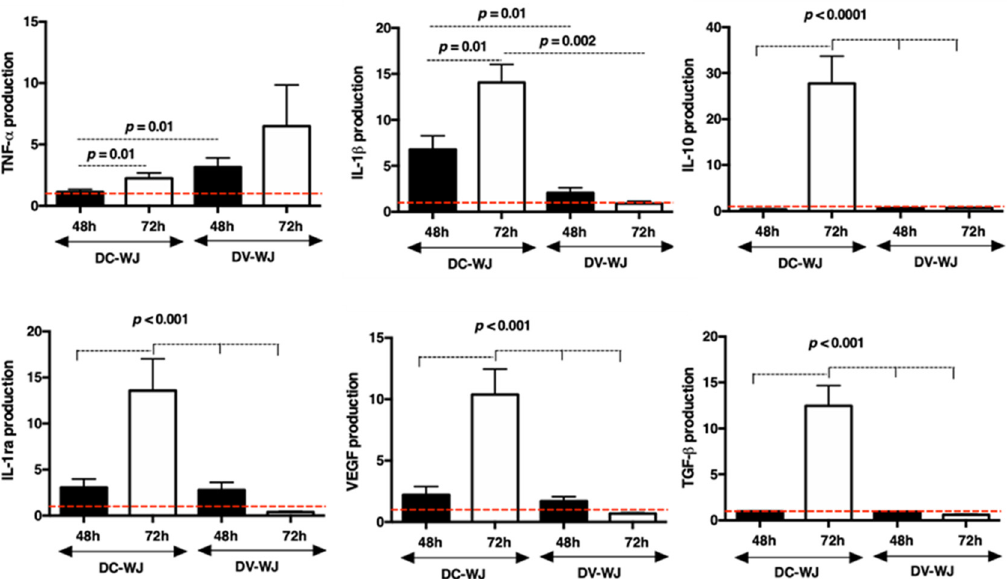
Figure 6. Macrophage polarization in the presence of decellularized and devitalized Wharton’s Jelly. Cytokine production following contact with DC- and DV-WJ. Results were normalized to DNA and M0 production, indicated by the red dashed lines; n = 4, Wilcoxon-Mann-Whitney test.